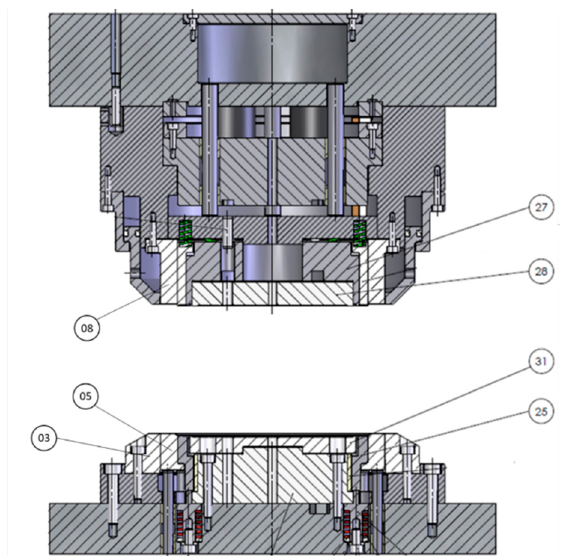
Figure 3. Punch and die drawings, showing their main components: 03—Die; 05—Pressure ring; 08—Cutting punch; 25—Draw ring; 27—Upper draw core; 28—Upper draw insert; 31—Lower draw core insert.